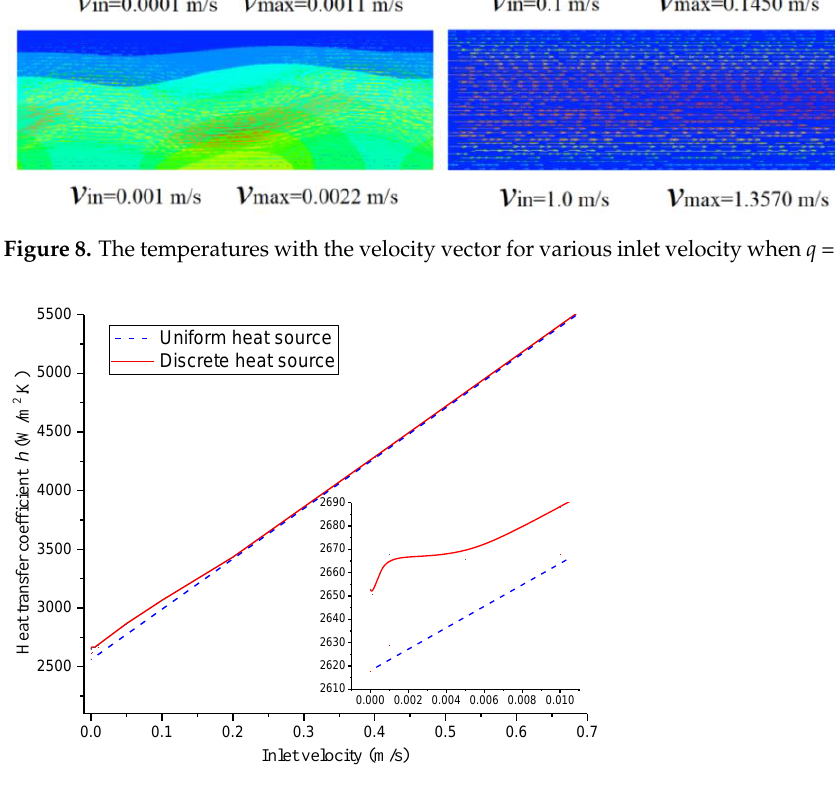
Figure 9. The variation of heat transfer coefficient with the inlet velocity for different heat sources, discrete and uniform heat sources.